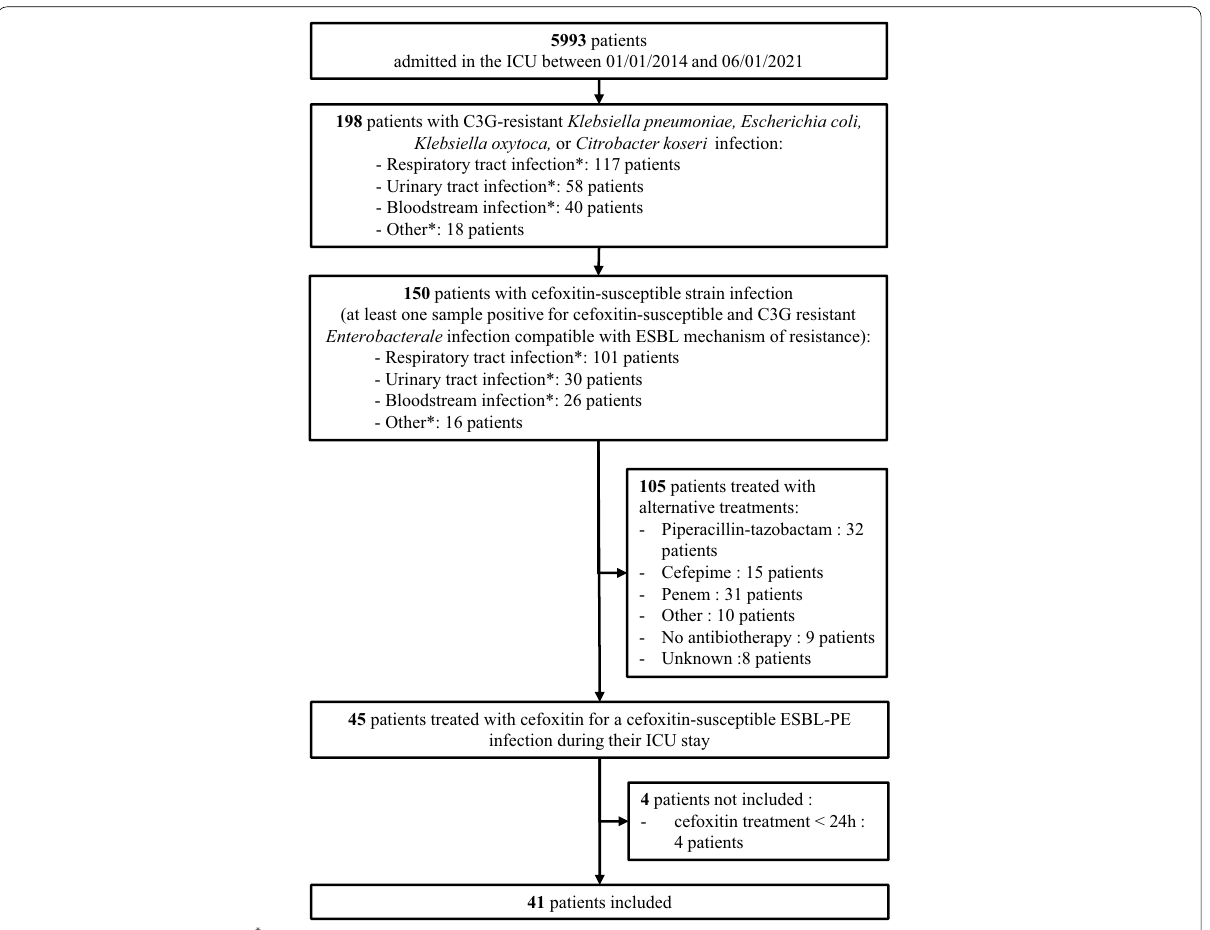
Fig. 1 Flowchart of the study. * Multiple sites could be positive for ESBL‑PE per patients. C3G 3rd generation cephalosporin, ESBL extended‑spectrum beta‑lactamase, ESBL-PE ESBL producing Enterobacterales, ICU intensive care